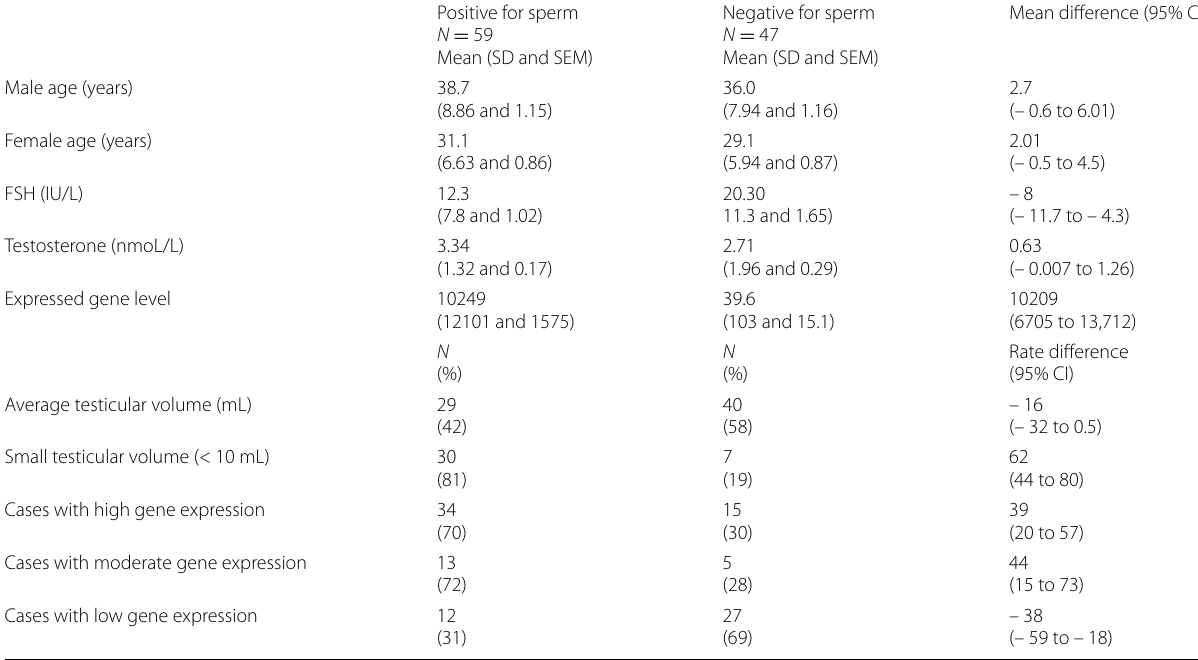
Table 1 Patient demographics in the study groups